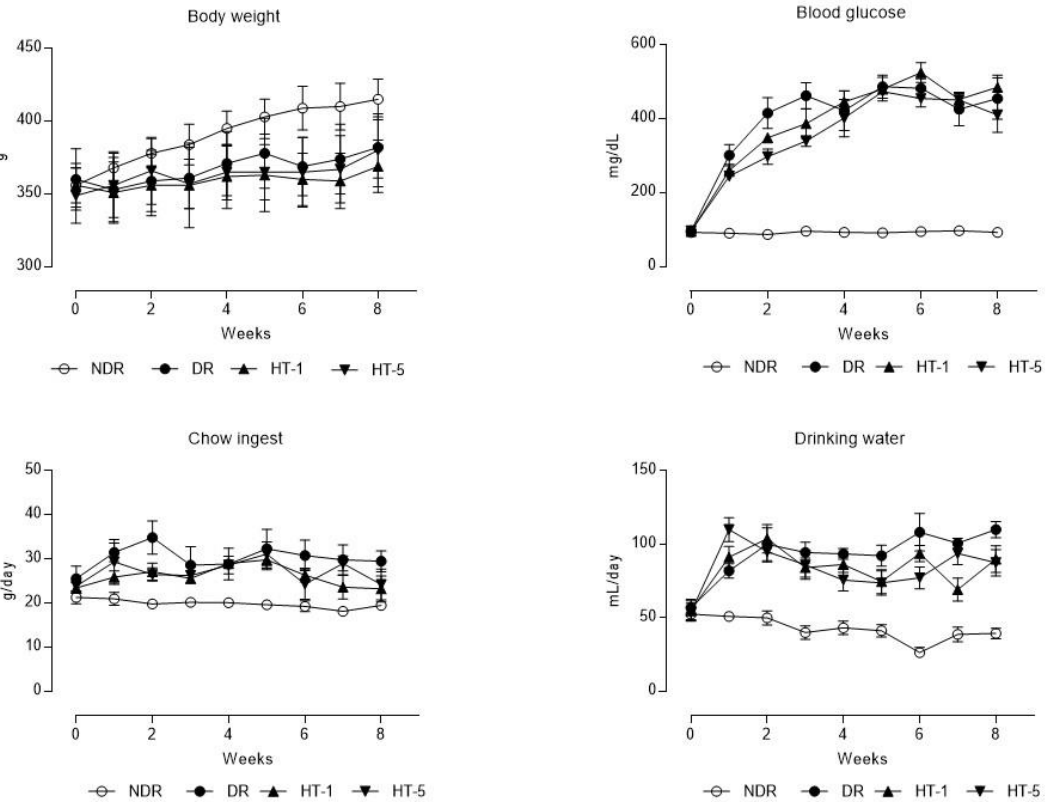
Figure 1. Time-course curves of the evolution of body weight, blood glucose, mean daily chow ingestion, and drinking water (mean ± standard error of the mean) in control nondiabetic rats (NDR), control diabetic rats (DR), and DR treated with hydroxytyrosol 1 mg/kg/day p.o. (HT-1) or 5 mg/kg/day p.o. (HT-5). N = 10 rats per group.